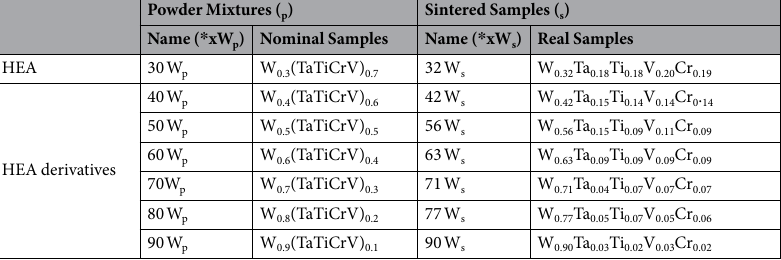
Table 1. Nominal and real composition of W x TaTiVCr samples (in